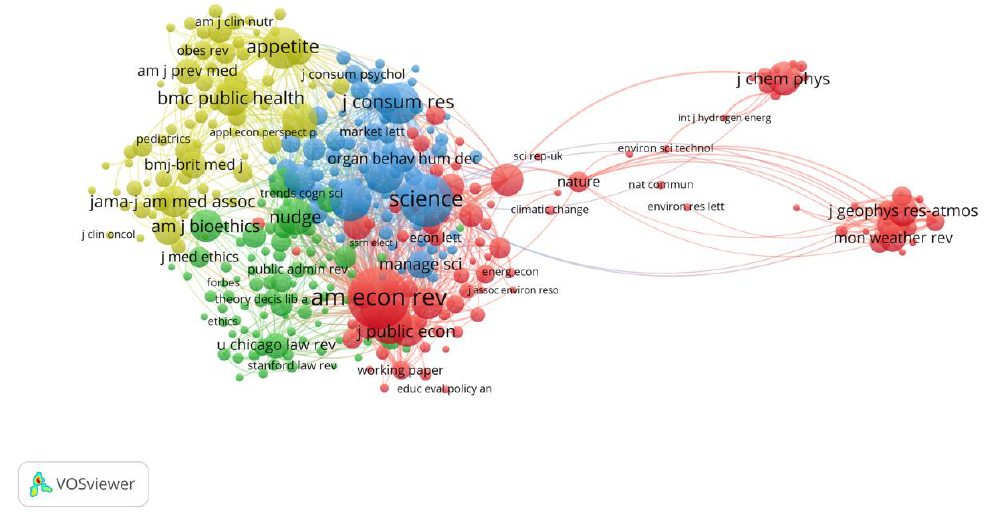
Figure 4. The co-citation network of journals.